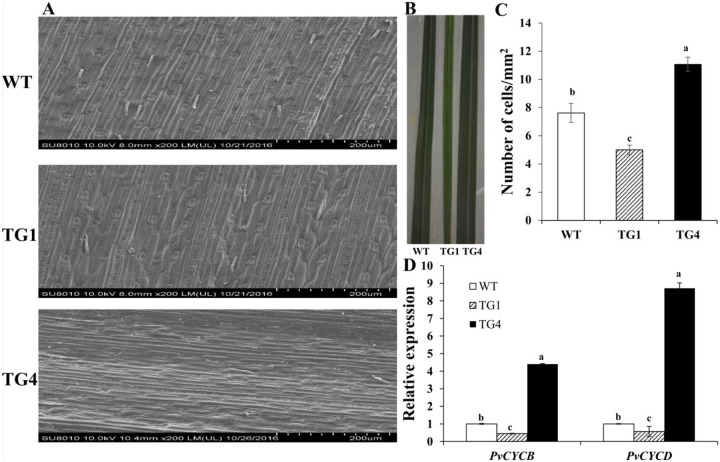
LpP5CS regulates cell size.(A) Scanning electron micrograph (SEM) imaging cells on the adaxial surface in the leaf of TG1, TG4 and WT. Bar = 200 um. (B) Leaf width and (C) cell number in TG1, TG4 and WT. Value are mean ± SE (n = 3). (D) Relative expression levels of PvCYCD and PvCYCB in transgenic plants and WT plants. Value are mean ± SE (n = 6). Switchgrass Ubq1 was used as the reference for normalization. The significance of treatments was tested at the P < 0.05 level (one way ANOVA, Dunnett’s test).